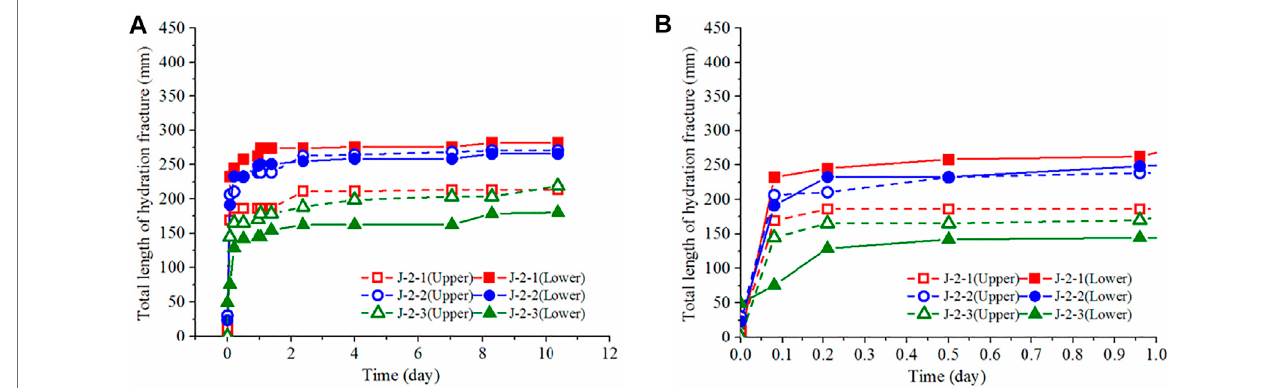
FIGURE 7 | Increase of the length of hydration fractures soaking in fracturing fl uid with time: (A) complete period, and (B) the fi rst day.